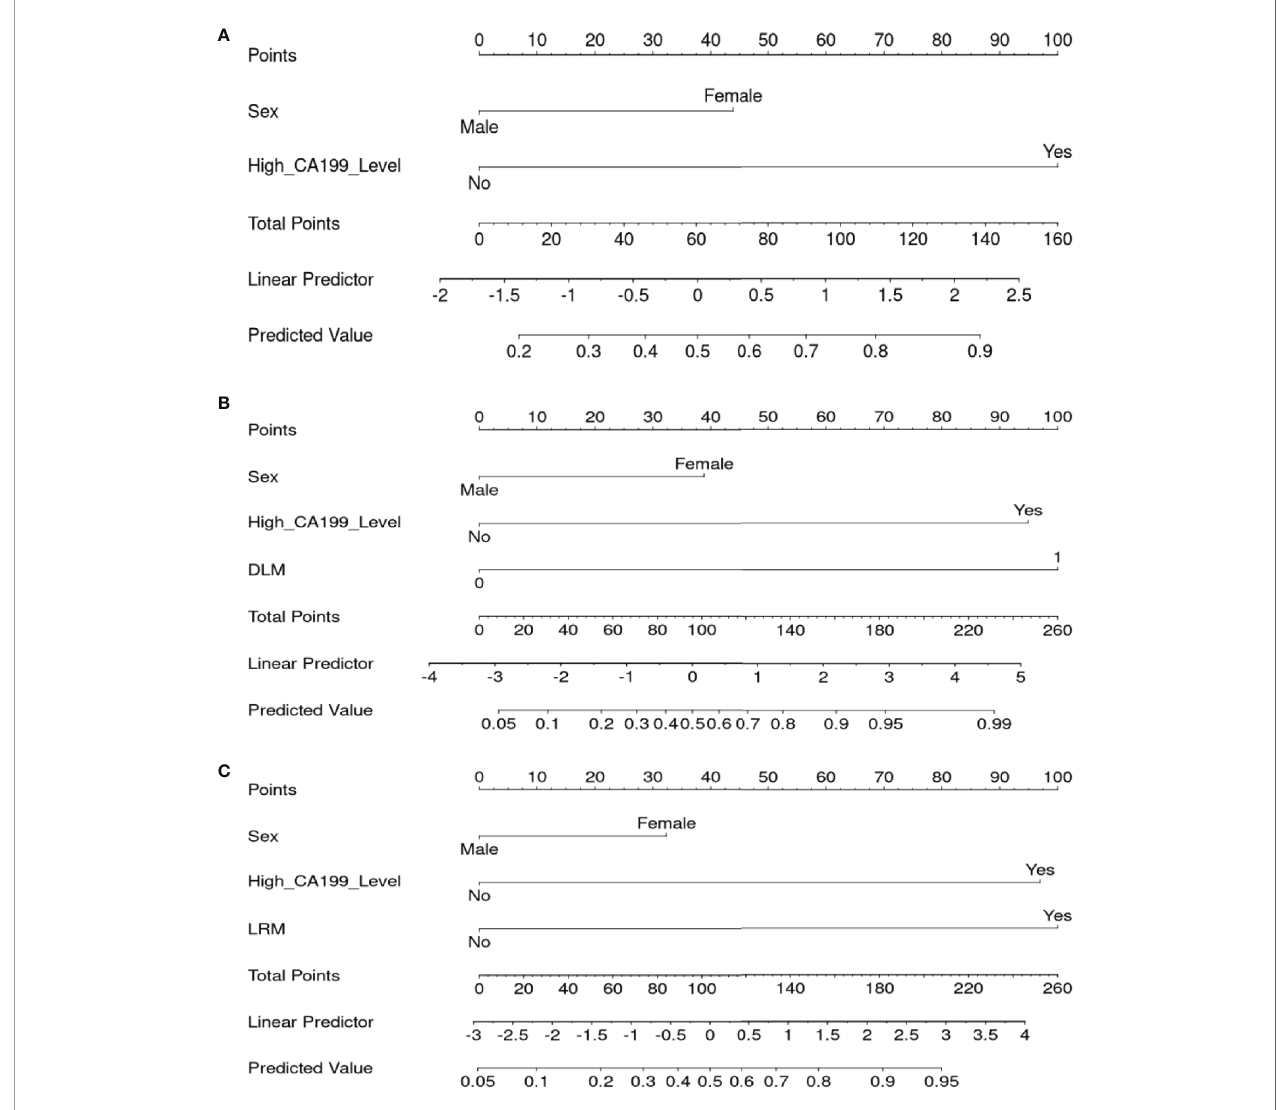
FIGURE 3 | Nomogram for the Clin (A) , US-DLM+Clin (B) and MRI LR-M (C) model for predicting probability of OM. DLM 0: HCC, 1: OM; Clin, clinical features; DLM, deep learning model; MRI, Magnetic Resonance Imaging; LR-M, liver imaging and reporting system category; CA199, cancer antigen 199; US,